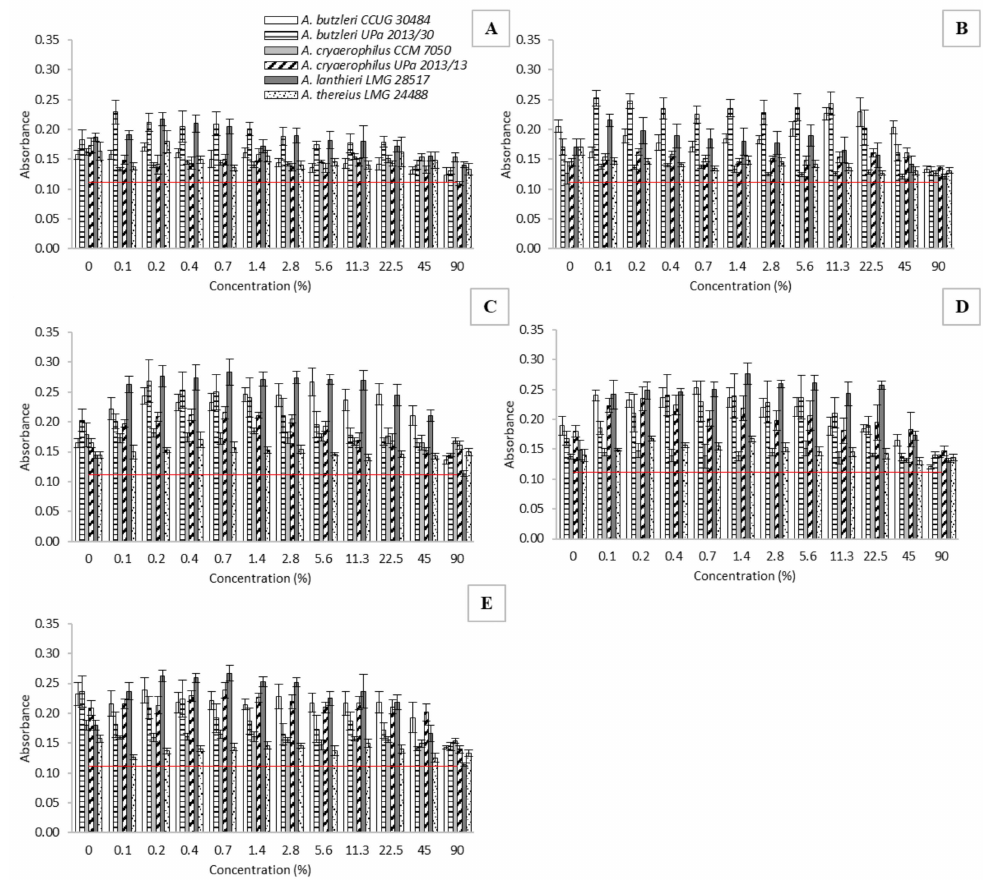
Figure 5. Biofilm formation in the presence of WEOO at a concentration of 90%; ( A )—extra virgin olive oil (Ballester); ( B )—extra virgin olive oil (Kyosos); ( C )—blended sunflower and extra-virgin olive oil (Ondoliva); ( D )—pure olive oil (Borges); ( E )—olive pomace oil (Ondoliva). The horizontal red line represents the influence of BHI broth (values under horizontal line—biofilm negative; values above line—biofilm positive). The results are presented as a mean ± standard deviation. Statistical significance between the groups was assessed by ANOVA at 5%